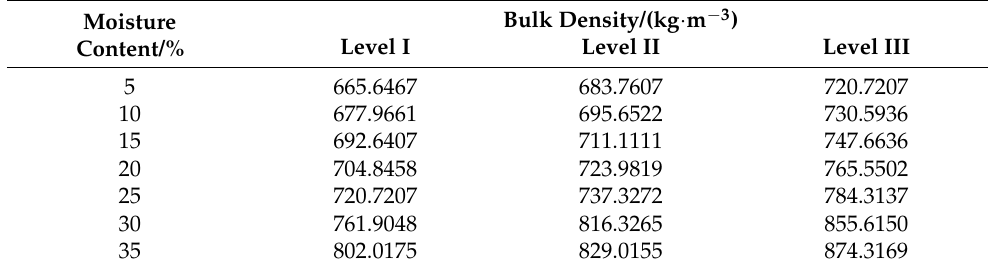
Table 1. Bulk density values of samples at various moisture contents.